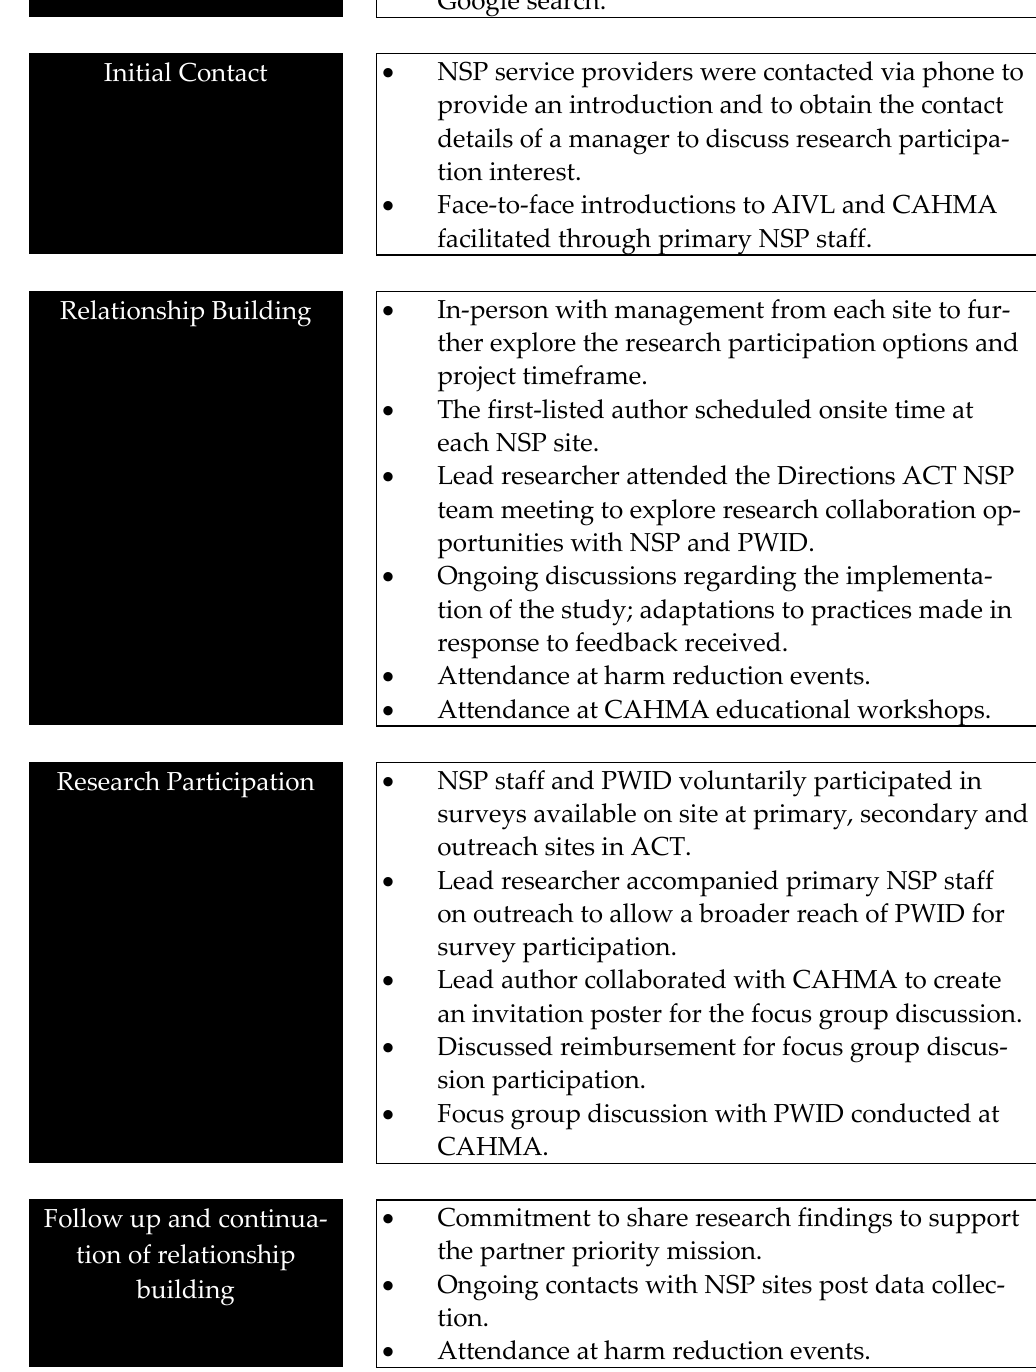
Figure 2. Process of relationship building. Note: Source is author’s original work.